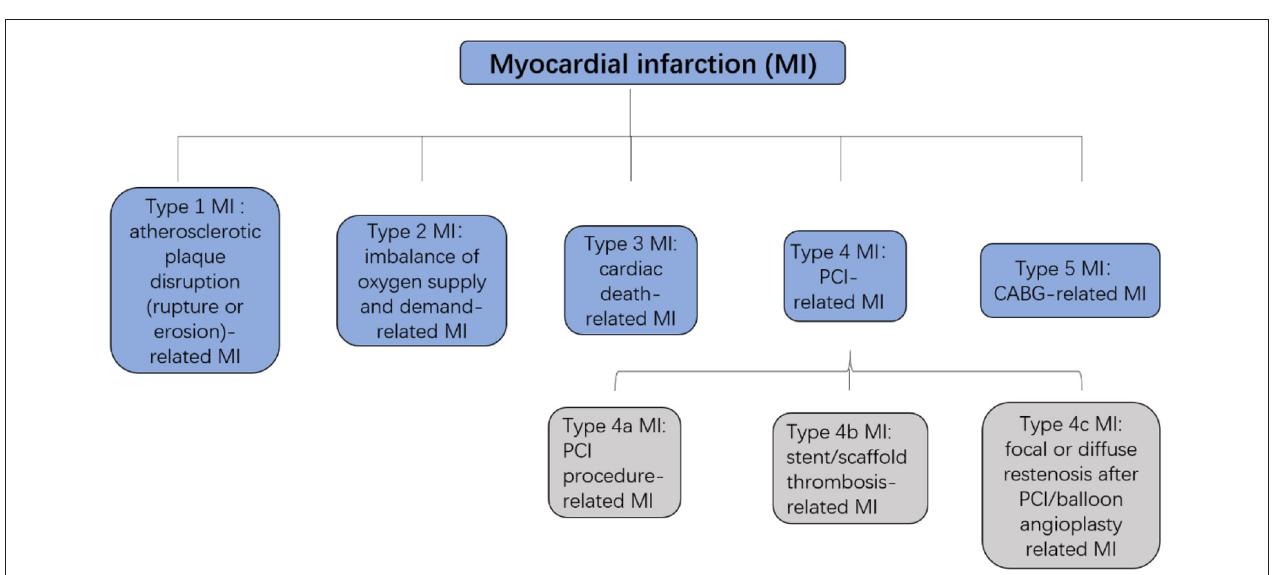
FIGURE 1 | Clinic defined acute myocardial infarction (AMI). cTn, cardiac troponin; URL, upper reference limit; AMI, acute myocardial infarction; A: Symptoms of myocardial ischemia; B: New ischemic ECG changes; C: Development of pathological Q waves; D: Imaging evidence of new loss of viable myocardium or new regional wall motion abnormality in a pattern consistent with an ischemic etiology; E: Identification of a coronary thrombus by angiography or autopsy (not for types 2 or 3 MIs).